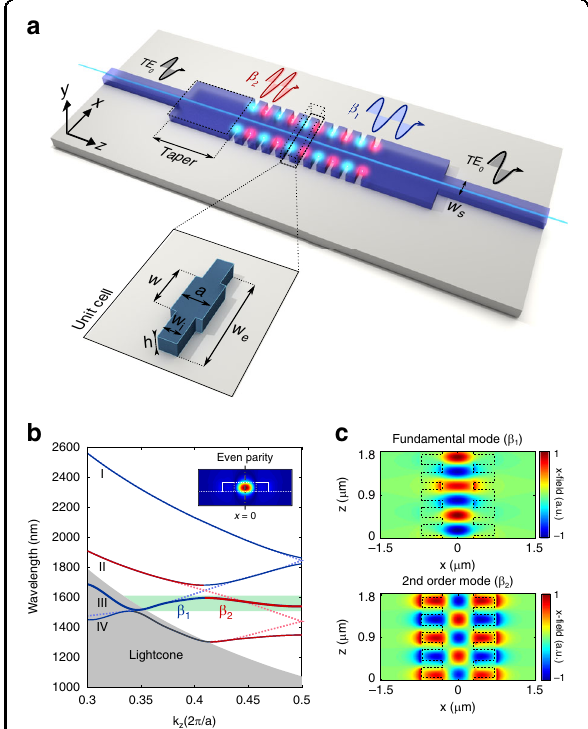
Fig. 1 Design and simulation of the 1D PhC. a 3D sketch of the proposed design composed of two single-mode waveguides at the input/output ports and a rectangular taper between the uniform and periodic bimodal parts. The inset shows the unit cell dimensions of the 1D PhC. b Dispersion diagram of the 1D PhC showing the fi rst three x -even parity bands for TE-like polarization. The blue lines depict the contribution of the fundamental mode to each band, and the red lines show the contribution of the higher-order mode. Dashed lines represent the hypothetical behaviour of the modes for a uniform non- periodic structure. The green shaded area indicates the bimodal region created in the proposed structure. The design parameters are a = 370 nm, transversal element width w i = 220 nm, transversal element length w e = 1400 nm, central waveguide width w = 600 nm and height h = 220 nm, and single-mode waveguide width w s = 450 nm. c Real part of the electric fi eld x -component for the fundamental and higher-order modes in the xz plane for y = 0. The fi eld patterns are calculated in the third band for k = 0.3652 π / a and z k z = 0.4752 π / a . The black dashed line represents the geometric shape of the silicon 1D PhC